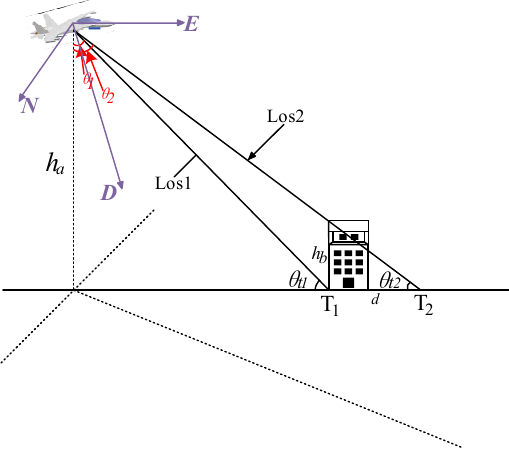
Figure 8. Geometric relationship of the linear array camera building imaging.